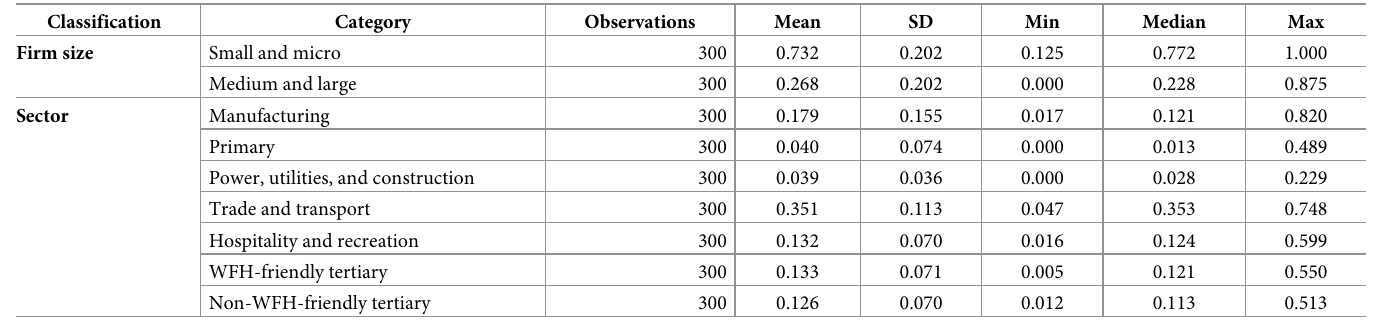
Table 1B. Summary statistics of city employment shares for top 300 destination cities and municipalities.